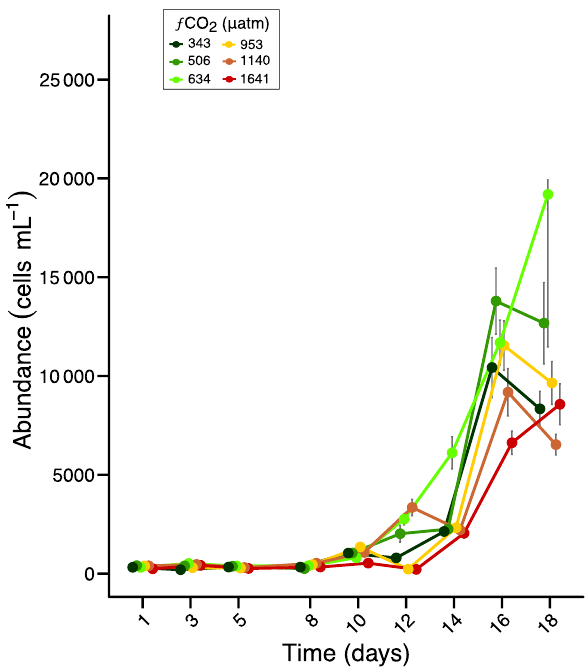
Figure 1. Abundance of total protists over an 18 day incubation of a natural protistan community in tanks maintained at different f CO 2 levels. Error bars are standard errors derived from pseudo-replicates undertaken at each time point for each